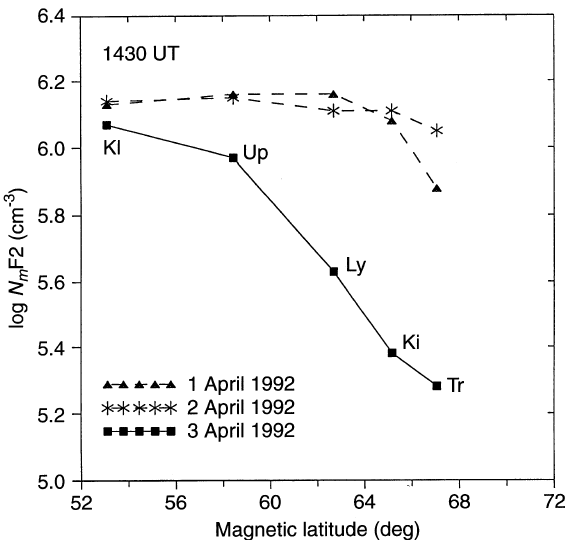
Fig. 7. Observed N F2 latitudinal variation for the chain of m European ionosonde stations: Kaliningrad, Uppsala, Lycksele, Kiruna and Tromso